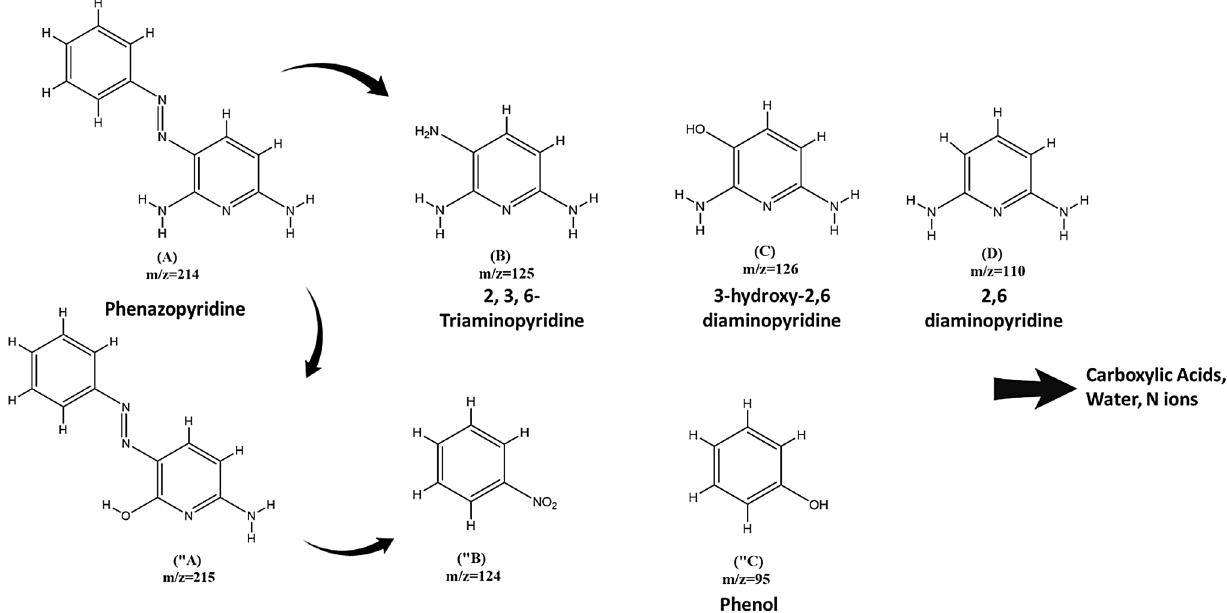
Figure 15. Proposed possible degradation pathways of PhP in catalytic ozonation processes using